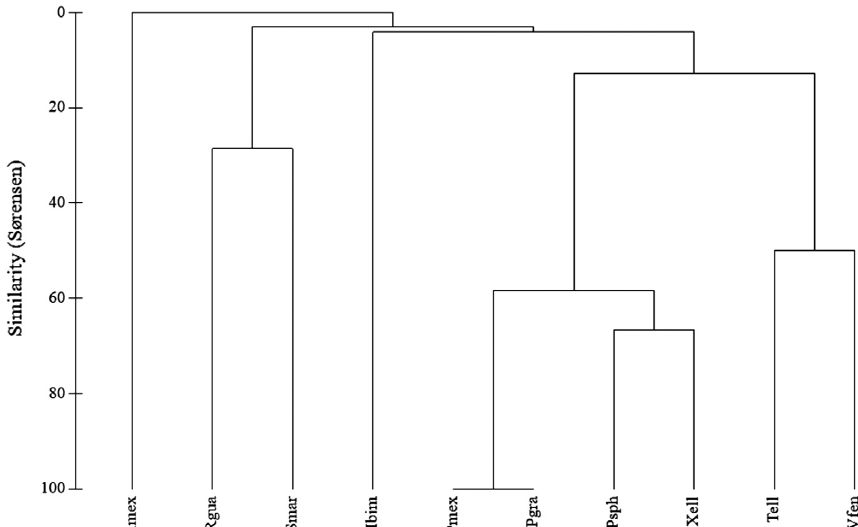
Figure 2. Dendrogram resulting from a similarity matrix based on the Sørensen measure for component communities of adult autogenic helminth parasites of 10 fish species from Apazapan, Río La Antigua, Veracruz, Mexico. Host species are: Amex, A. mexicanus ; Rgua, R. guatemalensis ; Smar, S. marmoratus ; Hbim, P. bimaculata ; Pmex, Poecilia mexicana ; Pgra, Poeciliosis gracilis ; Psph, Poecilia sphenops ; Xell, X. helleri ; Tell, T. ellioti ; Vfen, V. fenestrata .